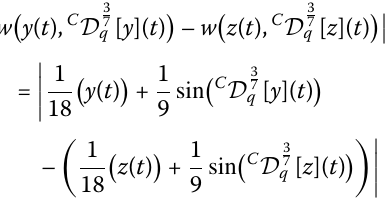
for y , z ∈ R . Then we